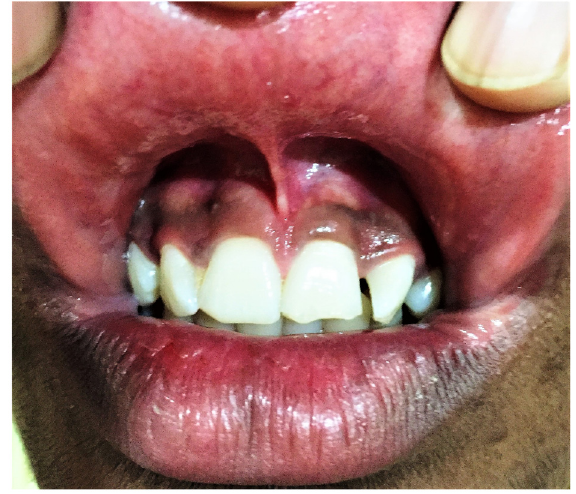
Figure 2. Mild desquamative gingivitis with gingival hyperpigmentation.